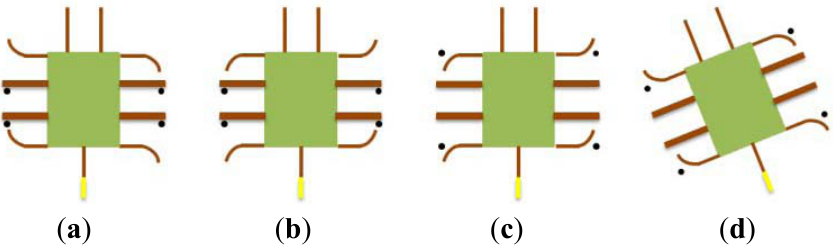
Figure 17. One step cycle of rotating motion in lying structure (The marks ● indicate which actuator contacts the ground).